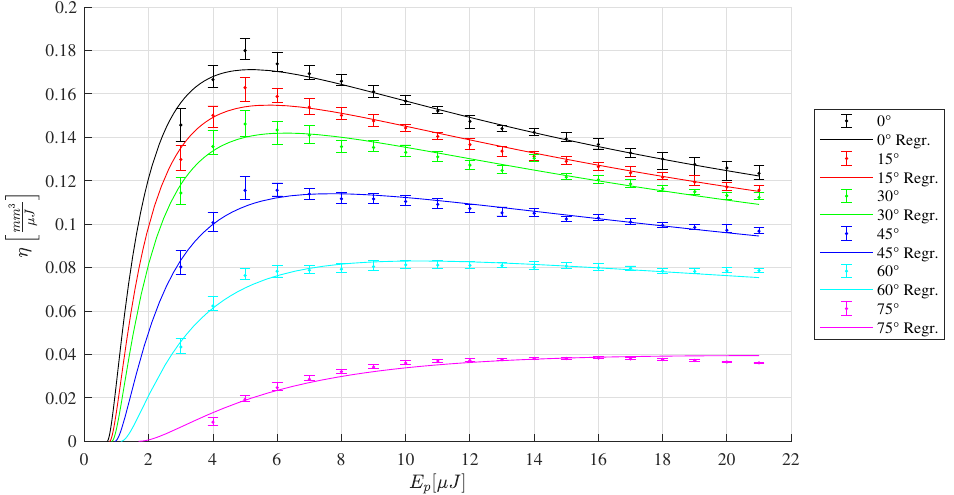
Figure 11. Ablation efficiency of LKT 550 for different inclination angles ranging from 0 ◦ to 75 ◦ . The corresponding regression of the ablation model [13] leads to the parameters F th (0 ◦ ) = 1.18Jcm –2 and δ (0 ◦ ) =